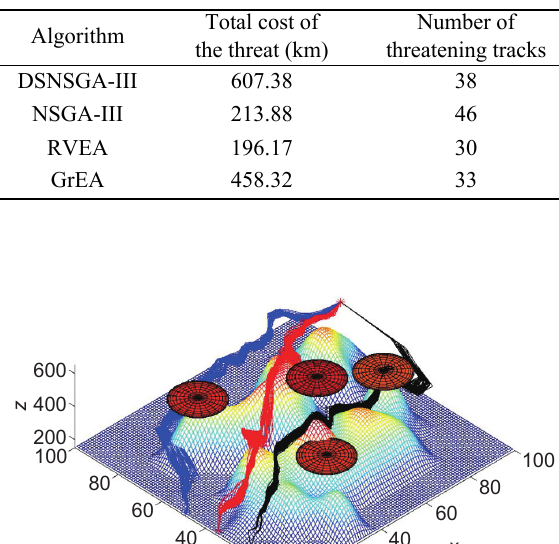
Fig. 5 Results of different objectives at different algorithms. Table 1 Values of the threat cost.